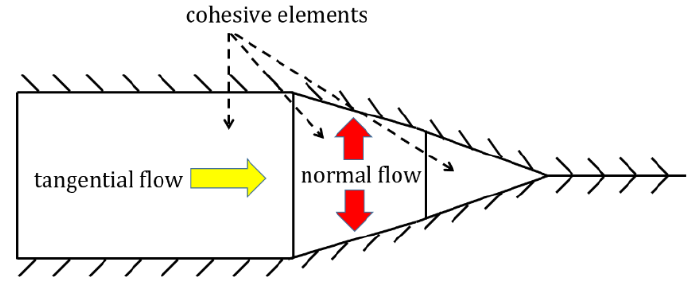
Figure 3. Fracturing flow pattern within fracture.